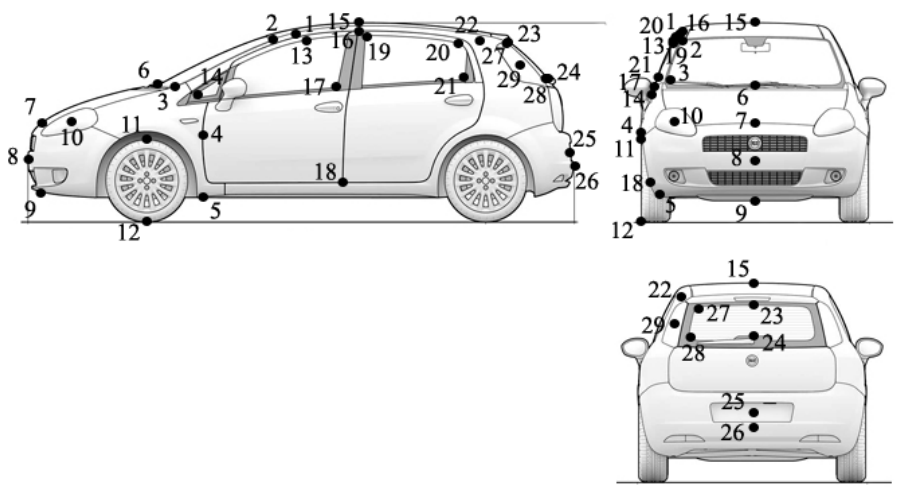
Figure 1. Landmarks used to quantify external car shape: ( 1 , 22 ) anterior and posterior upper-lateral corner of the roof of the car; ( 2 , 3 ) upper- and lower-lateral corner of the anterior glass; ( 4 ) maximum lateral convexity of the car at the level of the anterior part of the front door; ( 5 ) the lowest point of the bottom of the car at the level of the anterior part of the front door; ( 6 ) central-lower point of the anterior glass; ( 7 ) central-anterior point of the anterior hood; ( 8 , 26 ) central point of the anterior and posterior bumper; ( 9 ) the lowest central point of the anterior bottom part; ( 10 , 29 ) center part of the principal anterior and posterior light; ( 11 , 12 ) superior and inferior parts of the wheel; ( 13 , 14 ) upper- and lower-corner of the lateral glass of the anterior door; ( 15 ) superior center of the car at the level of the posterior part of the front door; ( 16 – 18 ) upper- and lower-posterior corner of the front door; ( 17 ) lower-posterior corner of the lateral anterior window; ( 19 , 20 ) anterior- and posterior-upper corner of the back lateral glass; ( 21 ) posterior-lower corner of the back lateral glass; ( 23 , 24 ) central-upper and -lower point of the posterior glass; ( 25 ) center of the posterior plate; ( 27 , 28 ) lateral-upper and -lower point of the posterior